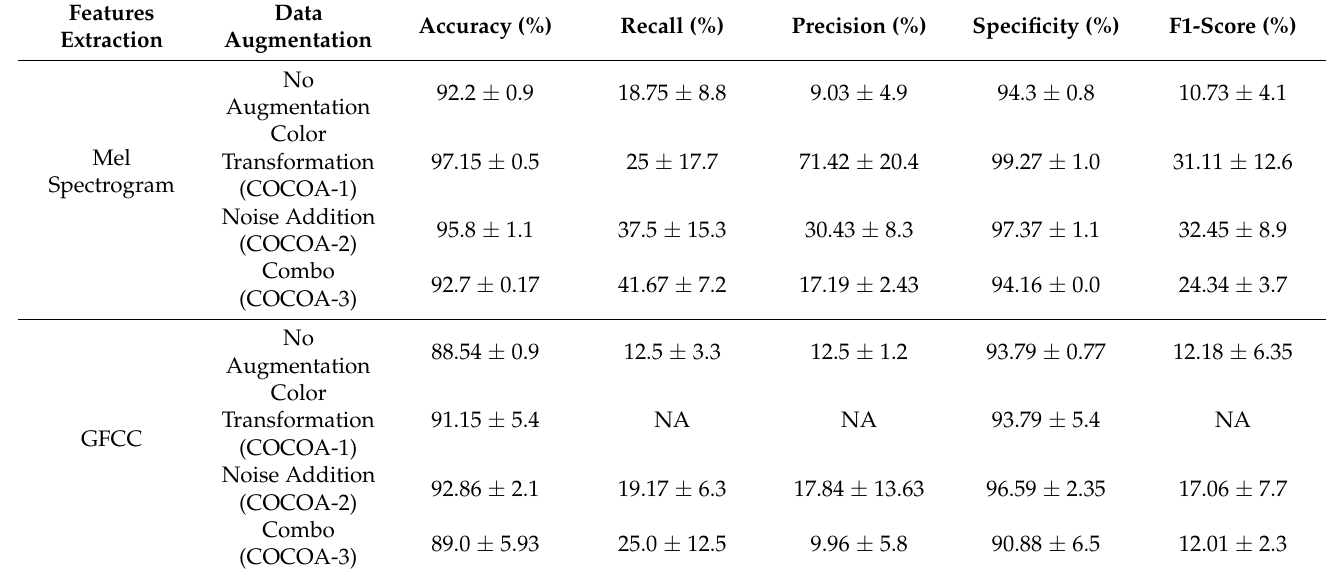
Table 8. Results Analysis of Positive Asymptotic vs. Healthy on applied feature extraction methods.